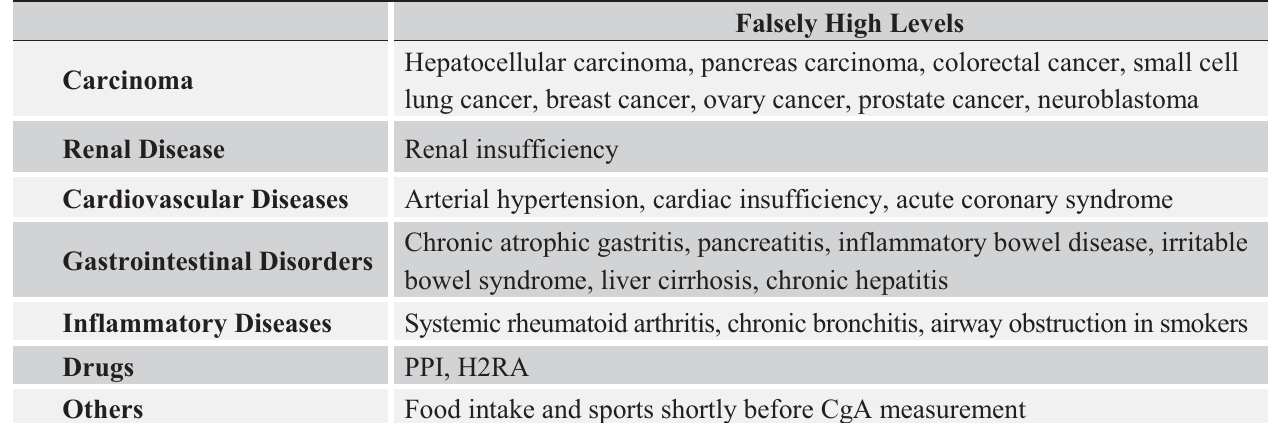
Table 11. Factors interfering with CgA